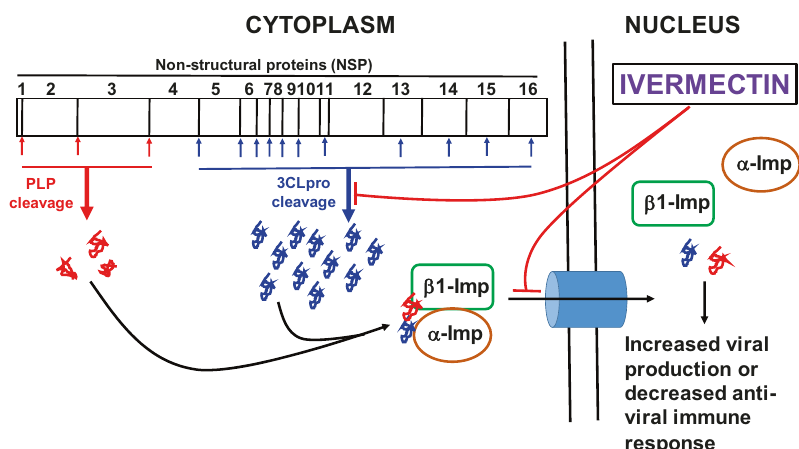
Fig. 8 Schematic representation of anti-viral mechanism of ivermectin. Hypothetical model illustrating the inhibition of SARS-CoV-2 replication by ivermectin mediated through the blocking of α / β 1-importin (imp) as well as 3CLpro enzymatic